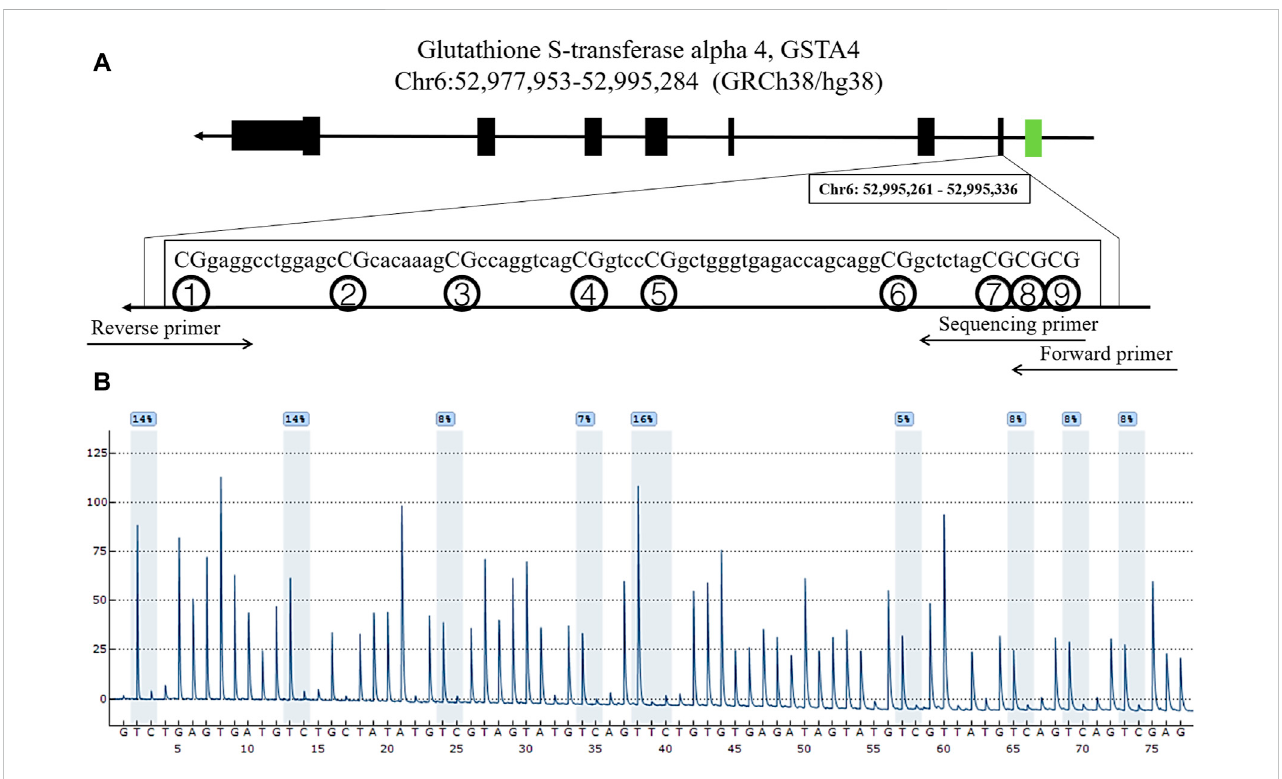
FIGURE 1 Locations and analysis of nine CpGs in GSTA4 . (A) The locations of the nine CpGs in the GSTA4 gene. (B) Representative sequencing analysis of nine methylation sites.